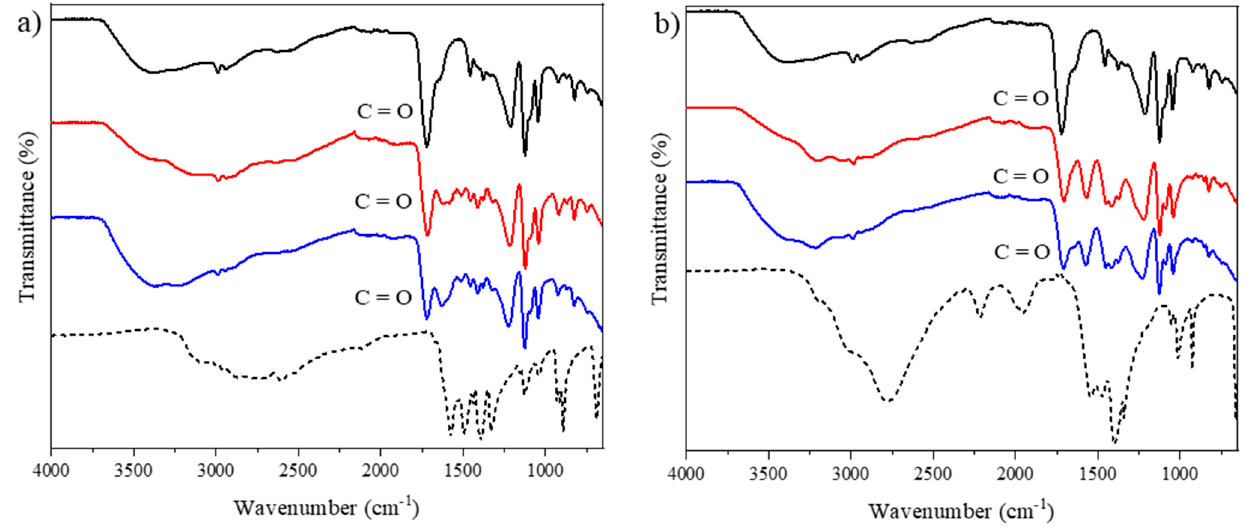
Figure 1. ( a ) FTIR spectra of — (black line) lactic acid, - - - - (dashed line) glycine, — (red line) lactic acid:glycine, — (blue line) lactic acid:glycine:water. ( b ) FTIR spectra of — (black line) lactic acid, - - - (dashed line) ammonium acetate, — (red line) lactic acid: ammonium acetate, — (blue line) lactic acid:ammonium acetate:water.